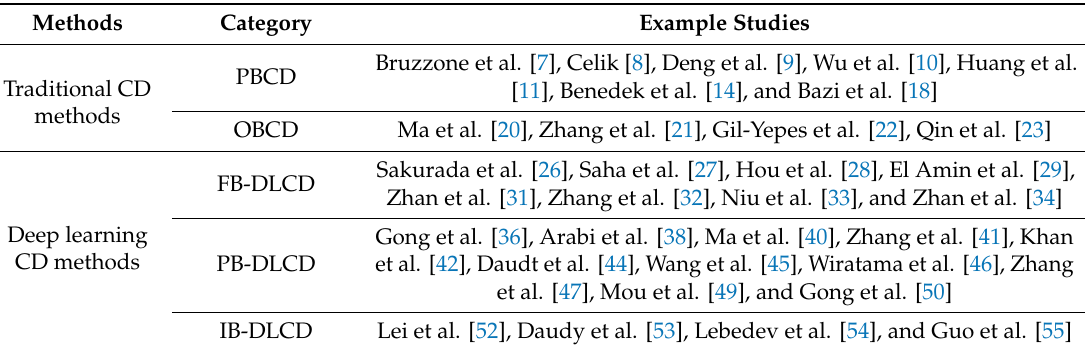
Table 1. Summary of contemporary CD